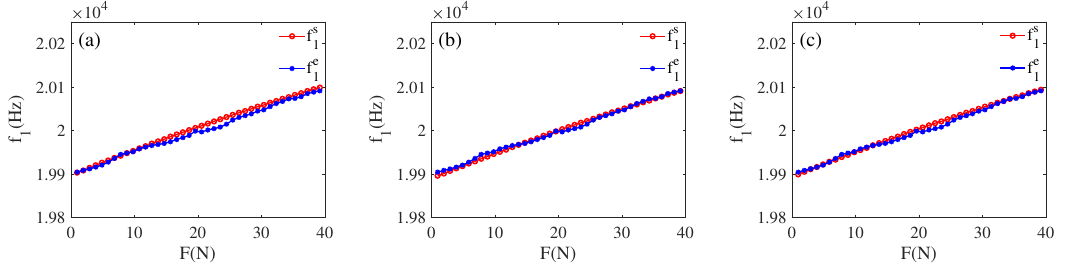
Figure 17. ( a ) f e